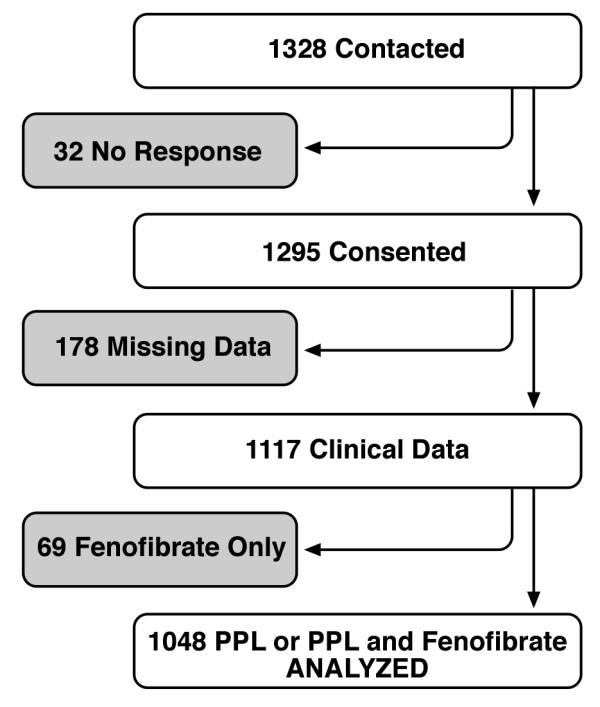
GOLDN study recruitment.